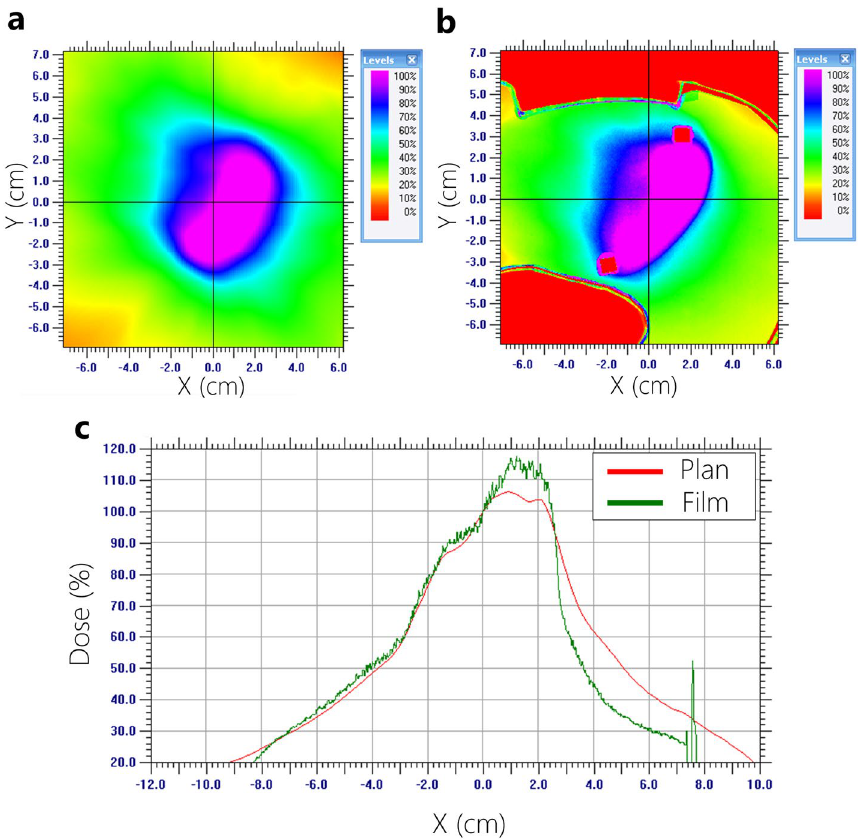
Figure 10. Dose profile analysis (measured film vs. planned dose) using 15-MV based on AAA Algorithm. ( a ) Planned dose, ( b ) measured dose, ( c ) comparison of dose